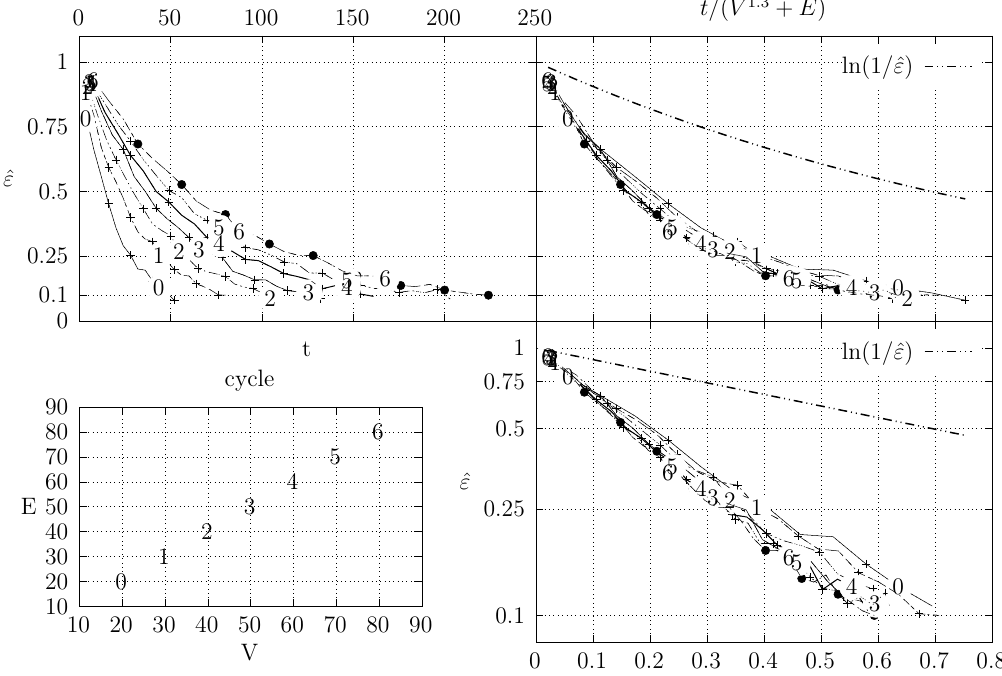
Figure 19. Estimation of variation distance as a function of the number of iterations for cycle graphs (see Section 4.3.1 for details).